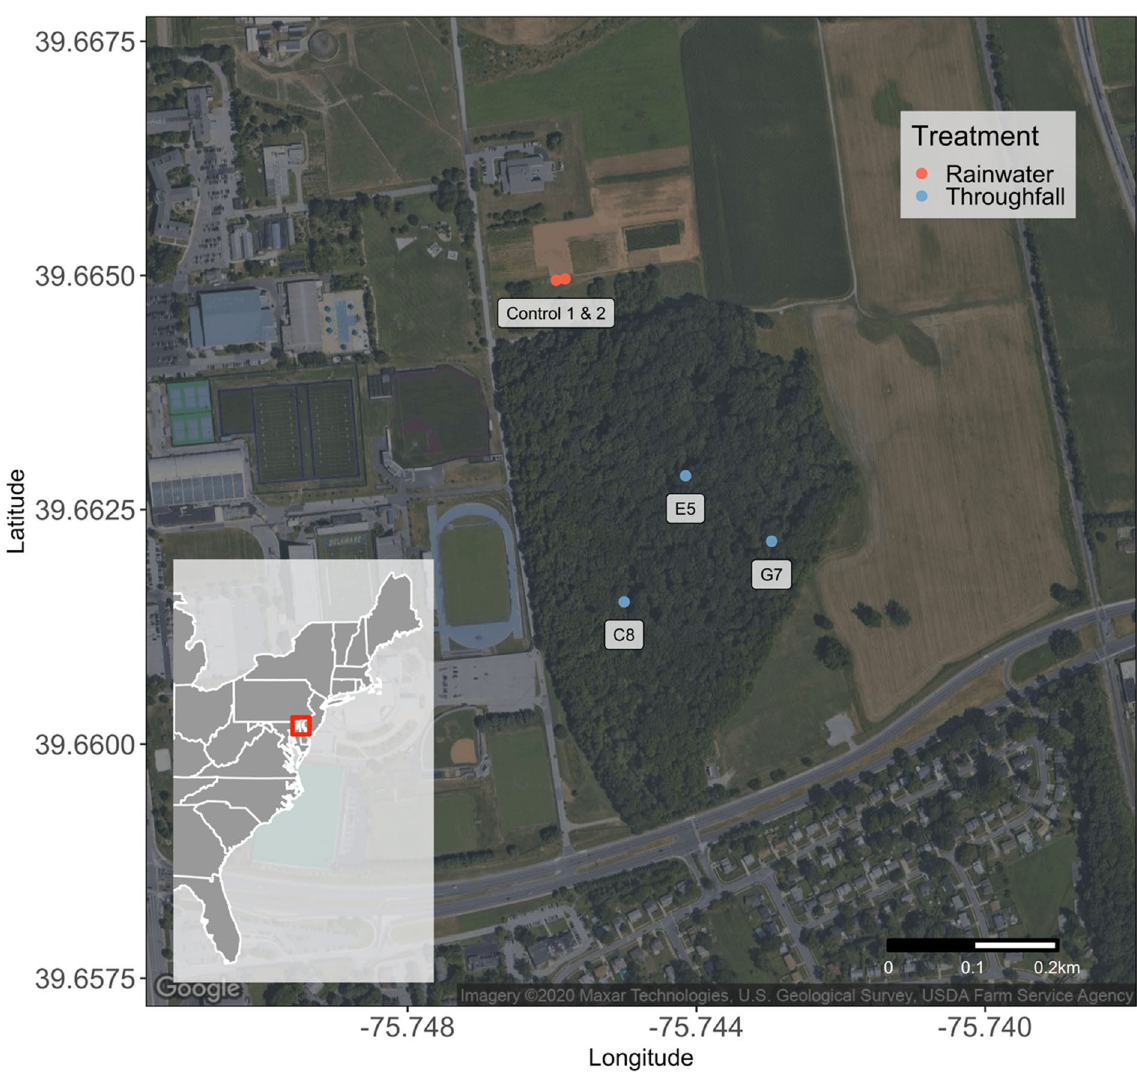
Figure 1. Map of study area showing sampling locations of rainwater (red) and throughfall (blue) treatments within and adjacent to the 16-ha forest (− 75.74477 W, 39.66249 N) in Newark, Delaware, USA. Map produced using program R (ver. 4.0.2; https ://www.r-proje